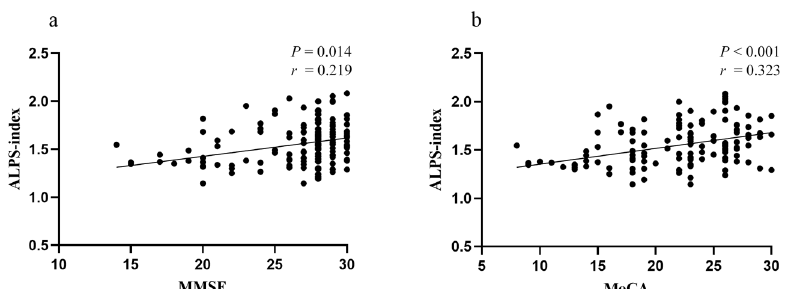
Figure 6. Correlation between ALPS-index and general cognitive function in all CSVD patients. ( a ) Positive correlation between ALPS-index and MMSE scores. ( b ) Positive correlation between ALPS-index and MoCA scores. Abbreviations: ALPS-index, the index of Diffusion Tensor Image Analysis along the Perivascular Space; CSVD, cerebral small vessel disease; MMSE, Mini-Mental State Examination; MoCA, Montreal Cognitive Assessment.